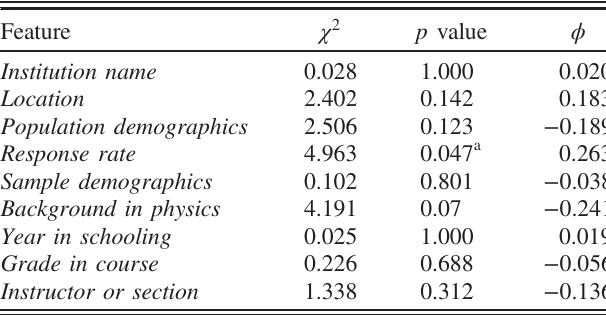
TABLE III. Fisher ’ s exact test results on institutional or course and sample